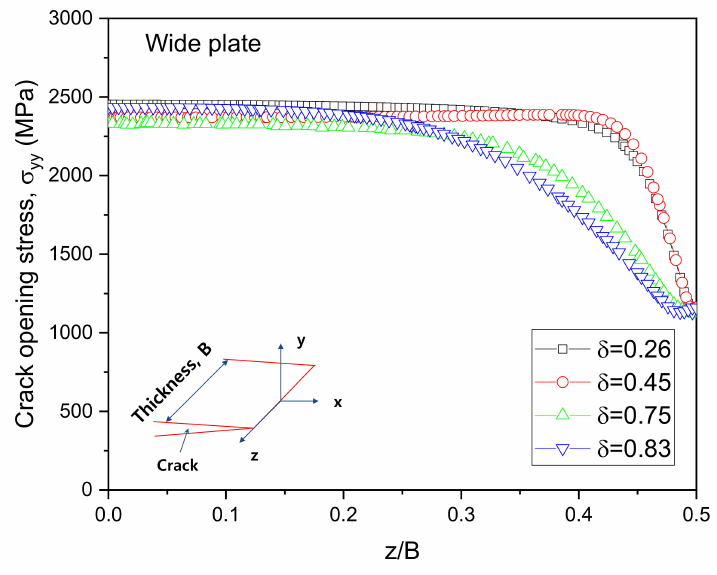
Figure 13. Opening stress distribution along the thickness for wide plate